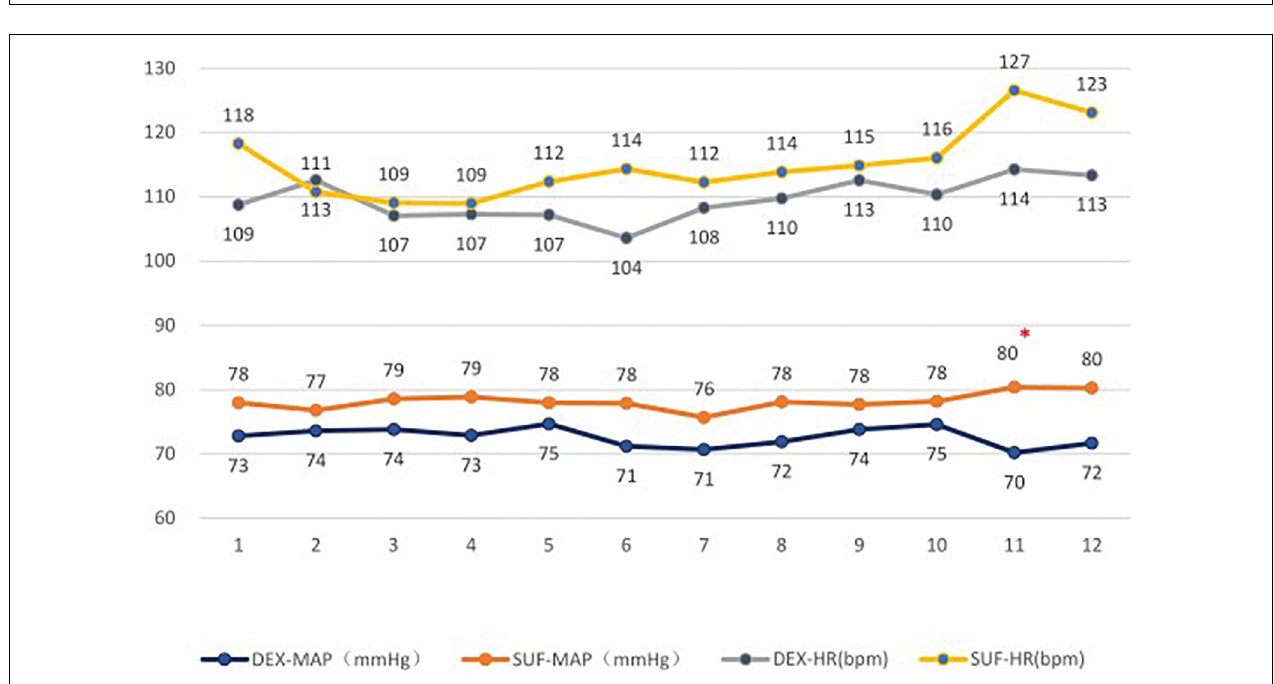
FIGURE 1 | Sleep stages of patients aged 1–6 years old in the SUF and DEX experimental groups. ∗ P < 0.05, from the comparison between the SUF and DEX groups.